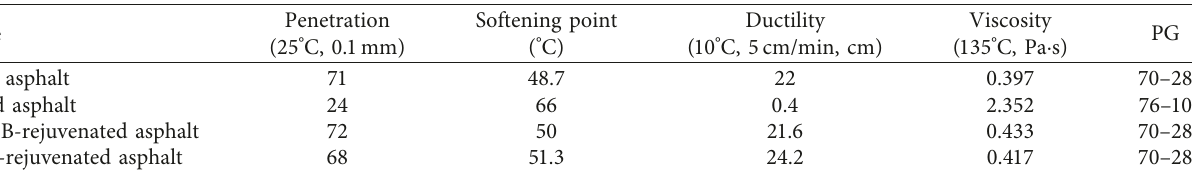
Table 2: Performance indexes of different asphalt binders.